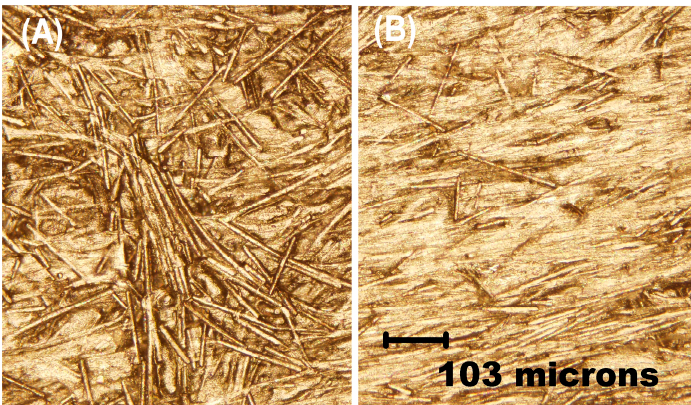
Figure 2. Photographs of the surface morphology of: ( A ) a bare conductive electrode; ( B ) an Sb-coated conductive electrode.